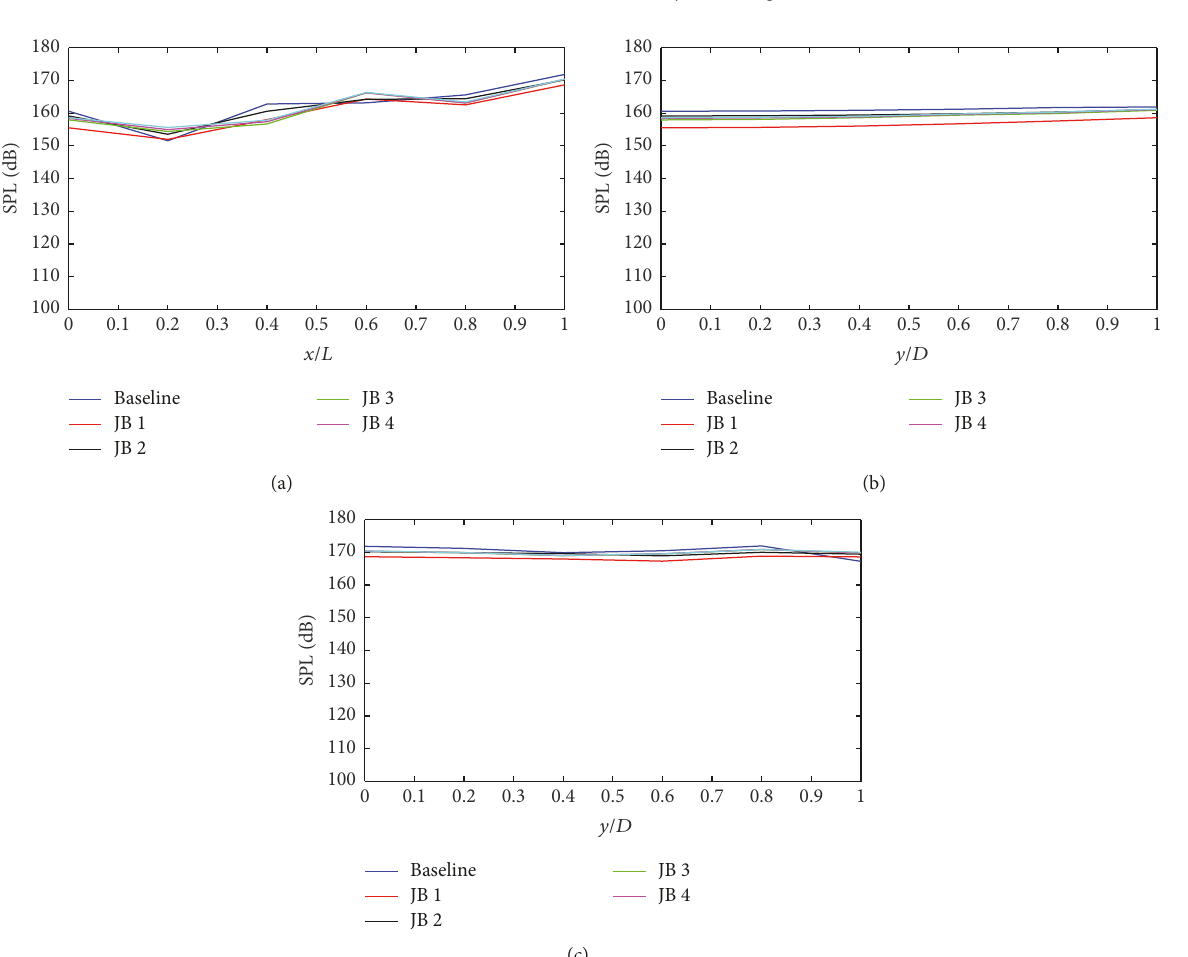
Figure 28: Location of holes for jet blowing.